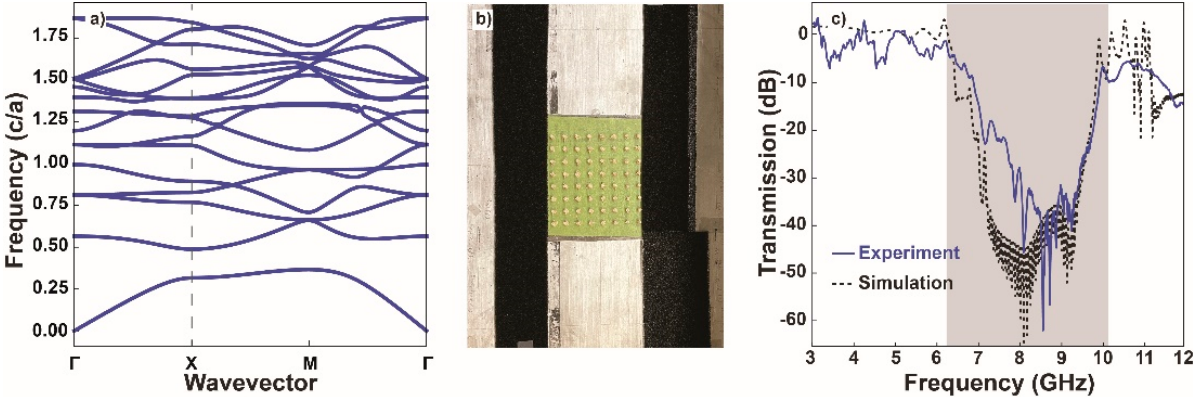
Figure 9. ( a ) Simulated band structure for a square lattice of dielectric rods. ( b ) Parallel-plate waveguide apparatus containing a 2D photonic crystal. ( c ) The measured and simulated (finite-difference time-domain) transmission through the crystal show excellent agreement with a ~45 dB decrease in transmission inside the photonic band gap (highlighted in grey). The direction along which the transmission was measured corresponds to the dashed line in ( a ).